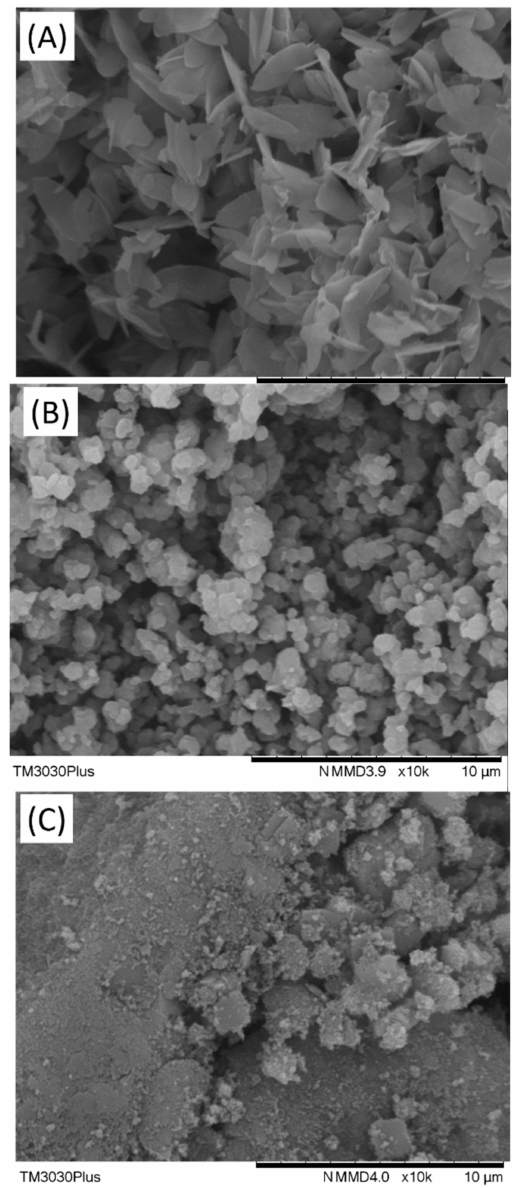
Figure 4. SEM image of the ZIF series used in the present study, ( A ) ZIF-L, ( B )ZIF-8, and ( C )